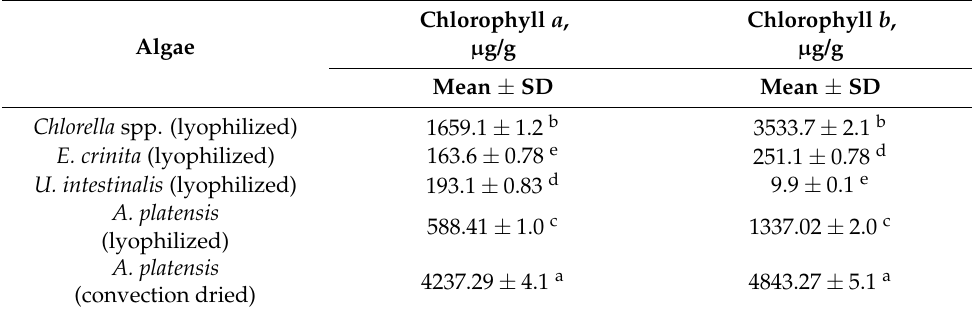
Table 8. Chlorophyll content in algae